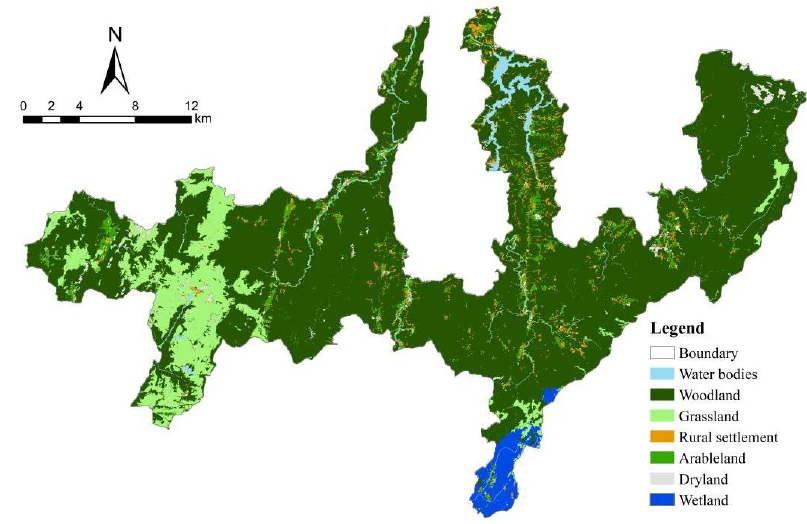
Figure 2. The 2016 land-use map of Hunan Nanshan National Park.